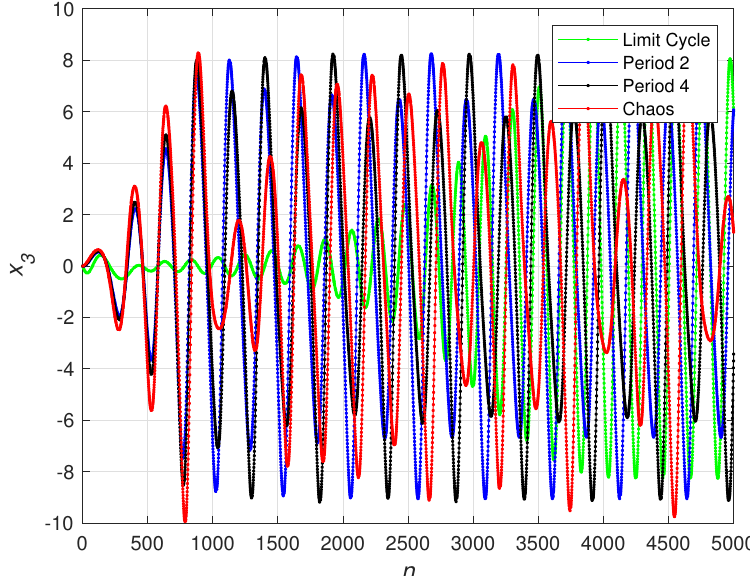
Figure 2. Time Series for for x 3 : Presence of multiple attractors in the proposed discrete-time map based chaotic jerk